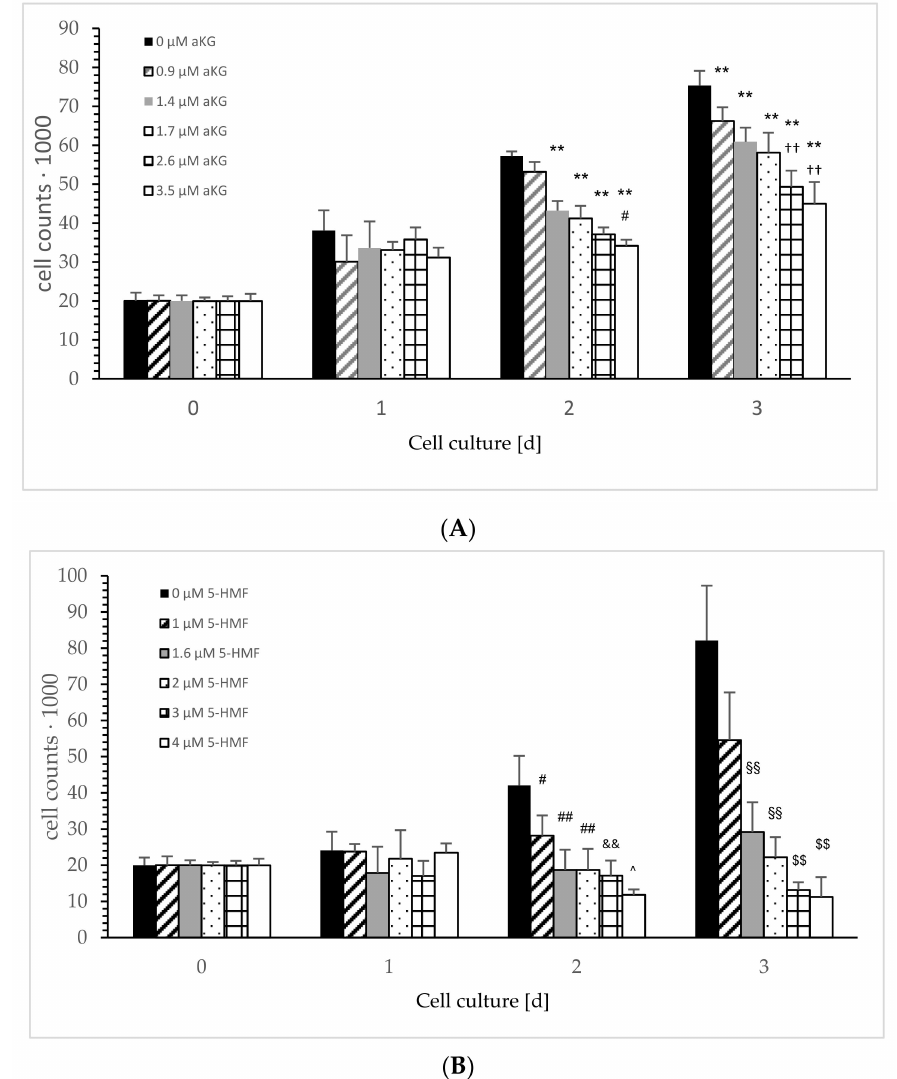
Figure 3. Cell growth of the Jurkat cell line in the absence or presence of different concentrations of 0, 0.9, 1.4, 1.7, 2.6 and 3.5 µ M aKG ( A ) or 0, 1, 1.6, 2, 3 and 4 µ M 5-HMF ( B ) after 24, 48 and 72 h of cultivation ( n = 5). ** p < 0.01: significance between 0.9 µ M aKG and 1.4 or 1.7 µ M aKG; †† p <